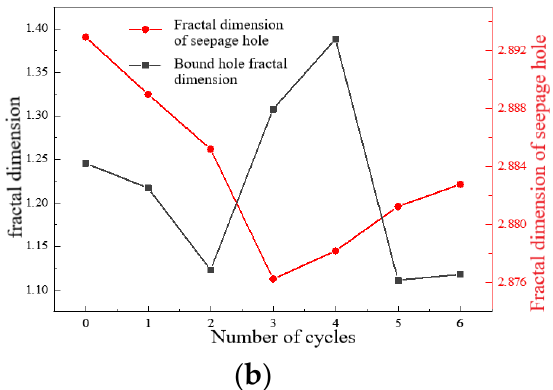
Figure 8. ( a ) Fractal dimension of initial state; ( b ) fractal dimension variation curves of various holes before and after freeze–thaw cycles.